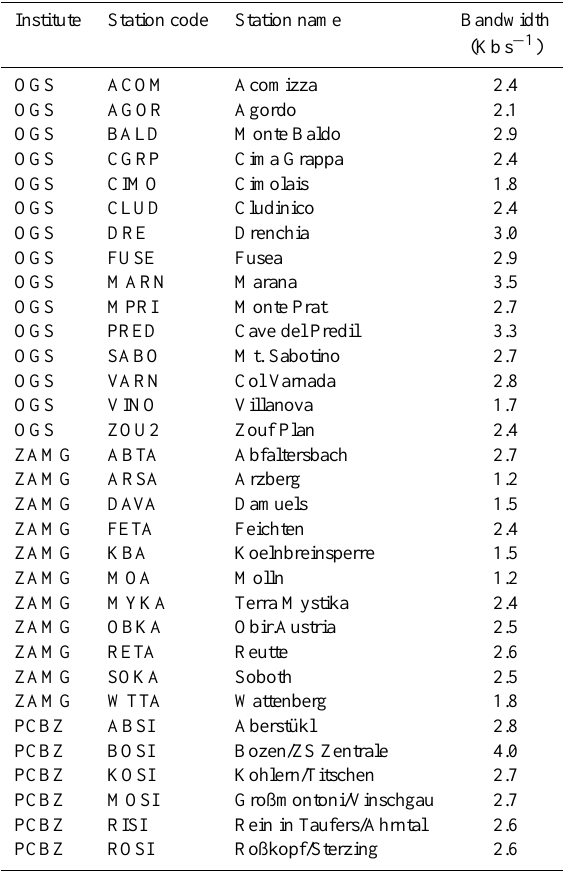
Table 1. Station list of Fig. 2 with bandwidth in Kbits − 1 .